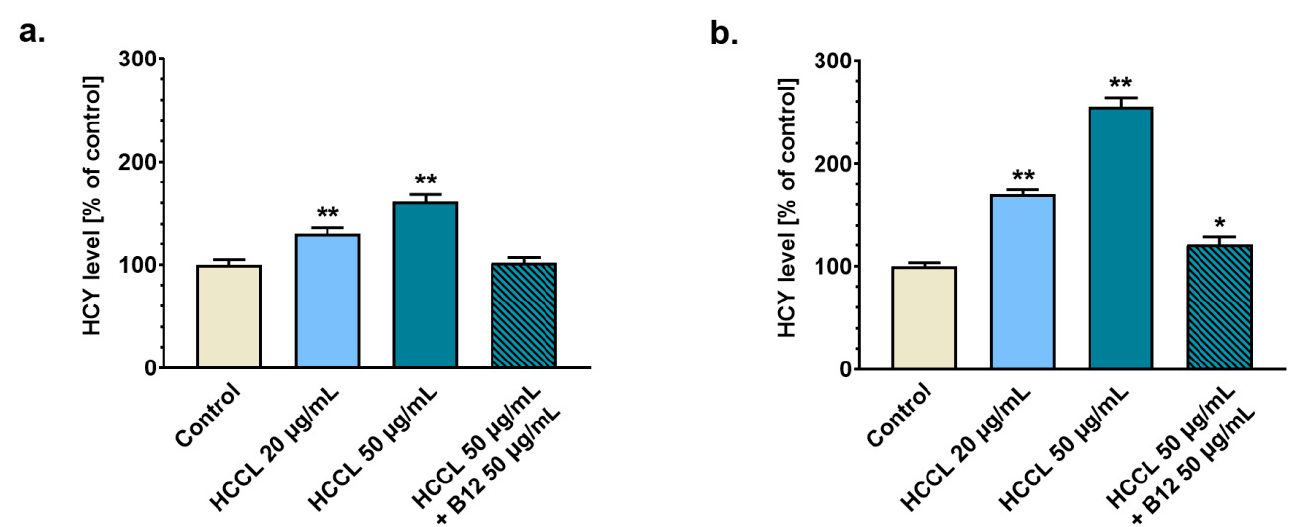
Figure 2. Homocysteine (HCY) level in culture medium after treatment with HCCL and/or B12. U-87 MG cells were cultured with hydroxycobalamin [ c -lactam] (HCCL) at concentrations of 20 and 50 µ g/mL or with HCCL (50 µ g/mL) in combination with B12 (50 µ g/mL). Untreated cells were cultured in parallel as a control. Data from quantitative analysis of HCY in culture media samples obtained on day 9 ( a ) and day 18 ( b ) of the treatment were calculated for total cell number and presented as % of control. Bars represent mean and SD of three independent experiments in at least triplicate; * p <0.05, ** p < 0.005 vs. control.